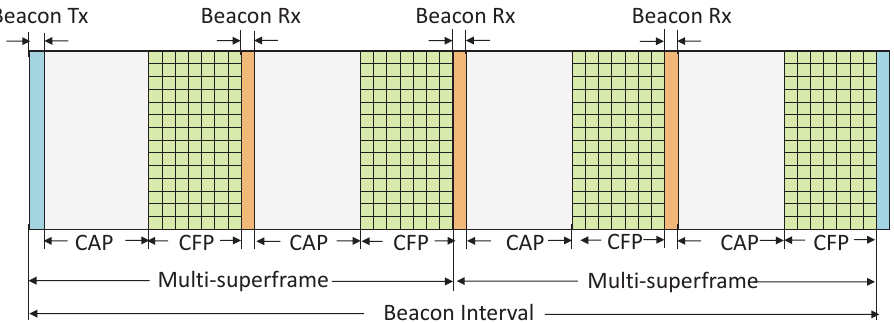
Figure 1. DSME superframe structure with BO = 6, MO = 5, SO =